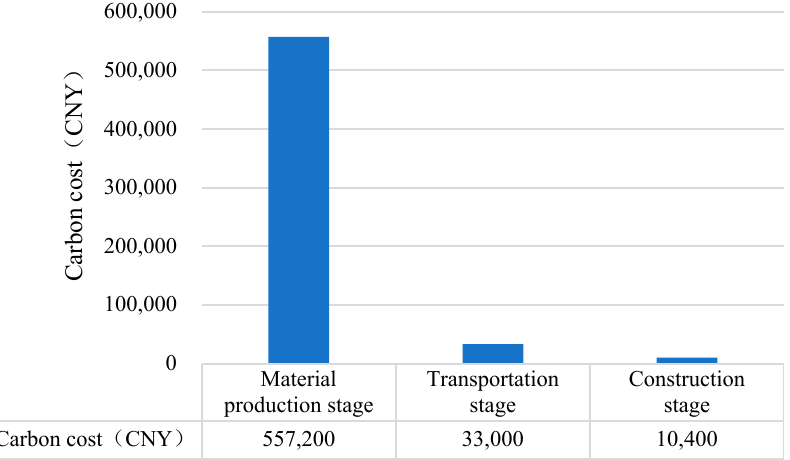
Figure 7. The carbon cost of the bridge construction stage under the carbon taxing system.